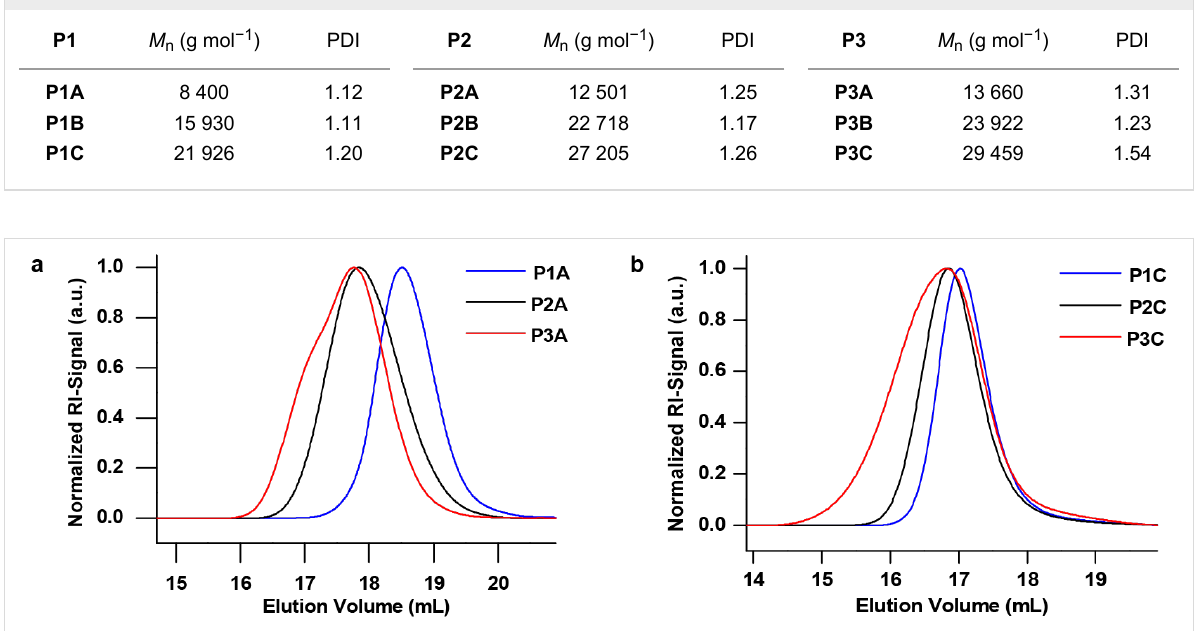
Figure 2: a) Size-exclusion chromatography of P1A (blue), P2A (black) and P3A (red) and b) size-exclusion chromatography of P1C (blue), P2C (black) and P3C (red) in hexafluoroisopropanol (HFIP). As expected, P2 shows a shift towards higher molecular weight, which confirms the success- ful synthesis of the block copolymer. P3 shows no further shift but a broader distribution, due to the dopamine group which interacts with the column